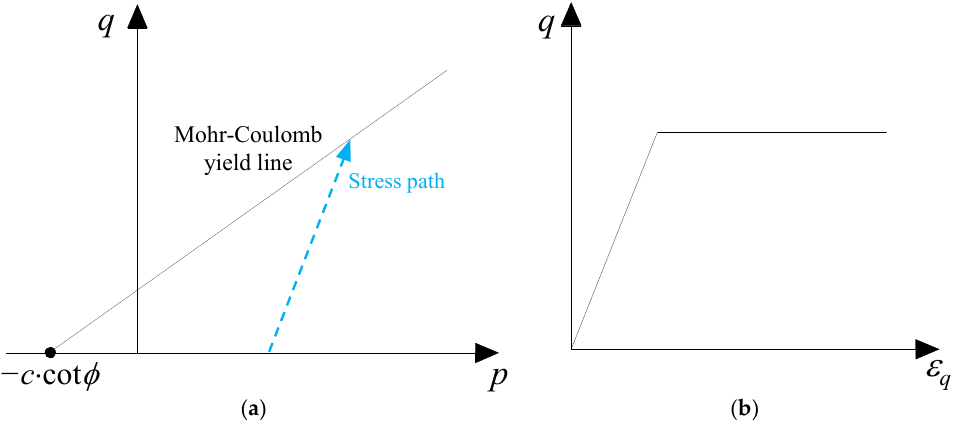
Figure 1. Schematic presentation of the Mohr–Coulomb elasto-plastic model: ( a ) yield surface in p – q space; ( b ) stress–strain relationship.